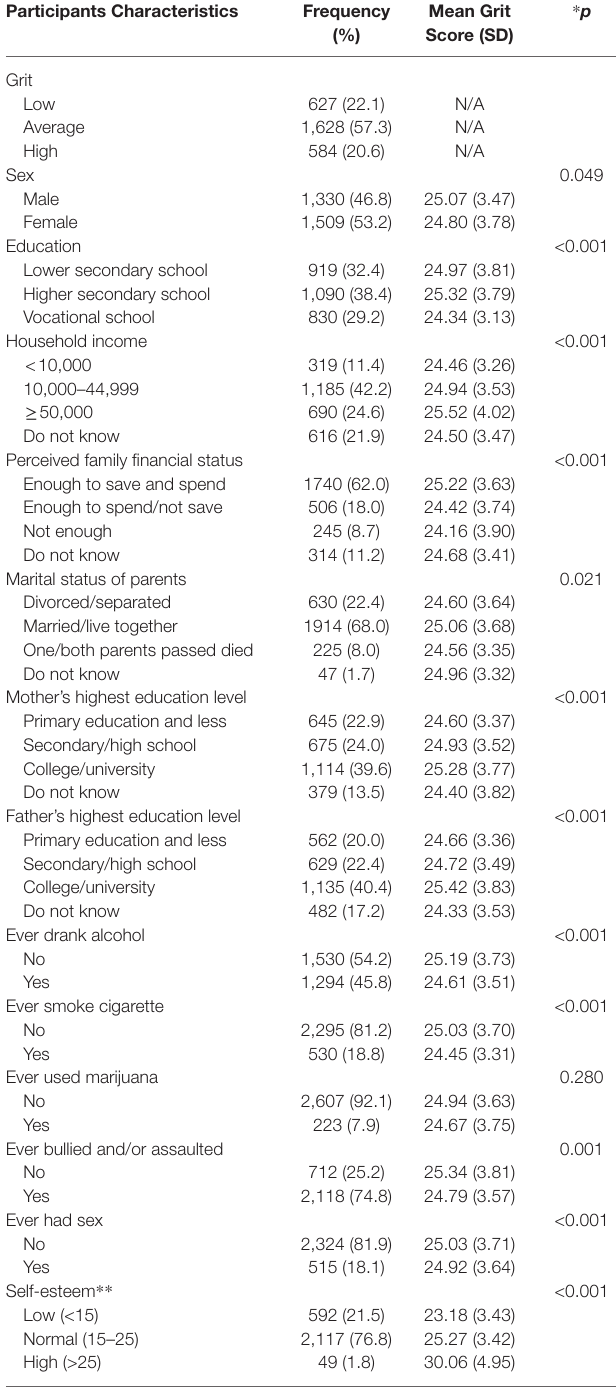
TABLE 1 | Participants’ general characteristics and bivariate analysis of factors associated with Grit (2,839 participants in total). Participants